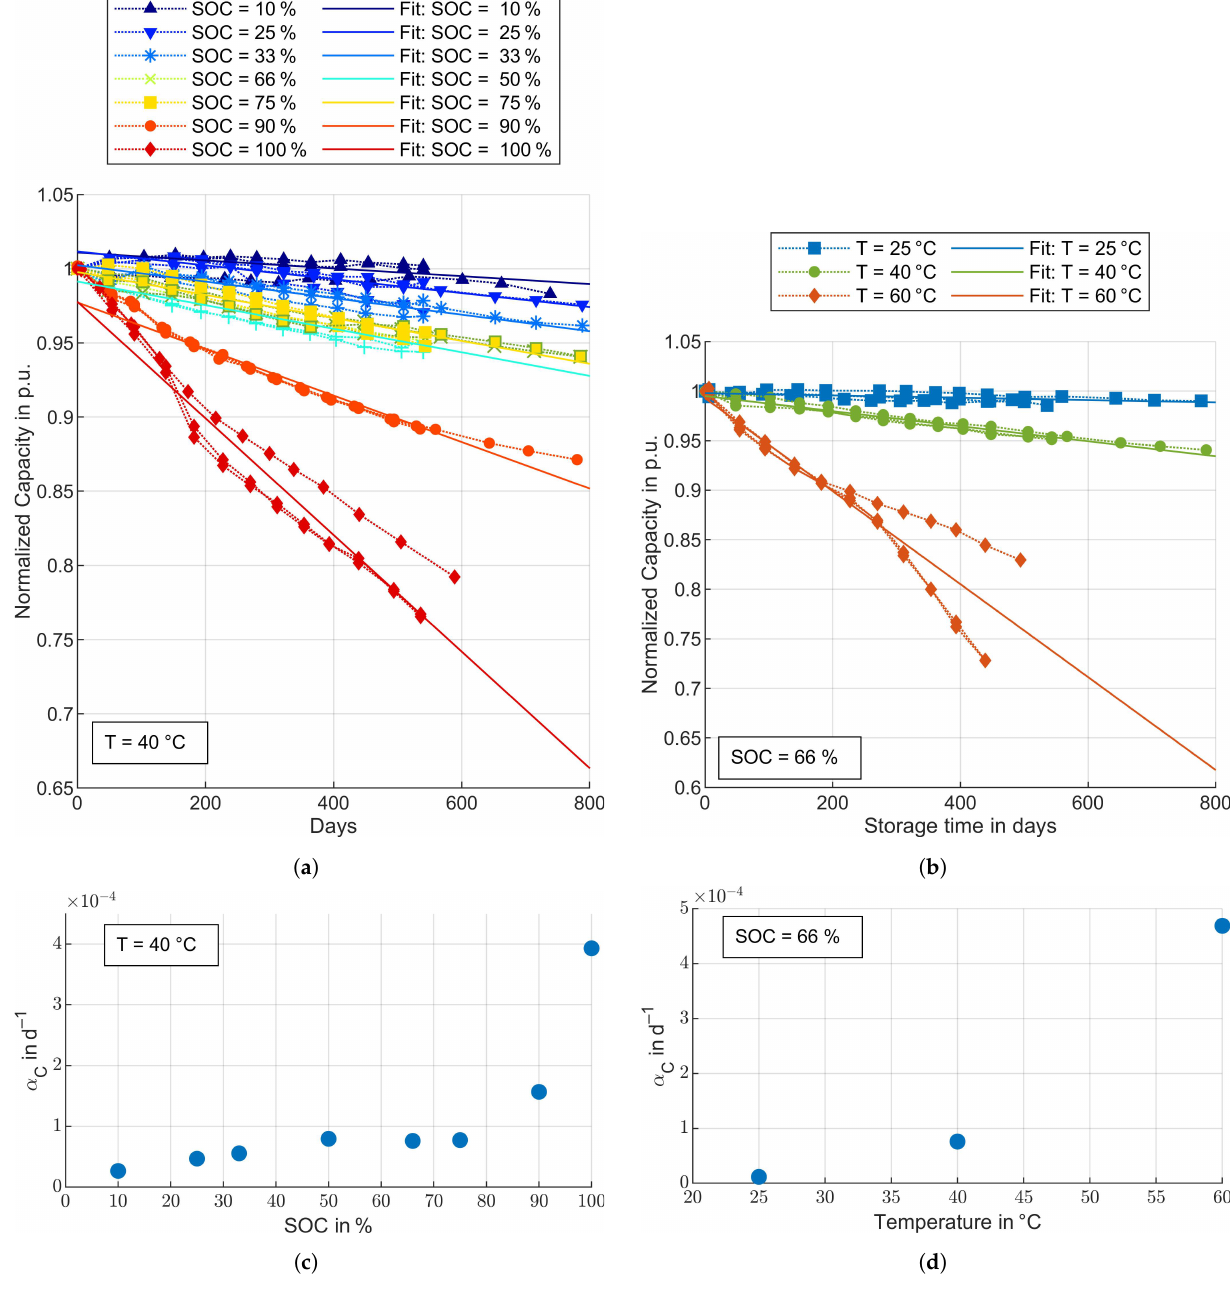
Figure 8. Capacity test and time fit results for cell capacity in calendar aging tests. ( a ) Capacity test and time fit results for cells stored at 40°C in the calendar aging tests; ( b ) Capacity test and time fit results for cells stored at 66% SOC in the calendar aging tests; ( c ) Linear coefficient α C of the time fit results for cells stored at 40°C in the calendar aging tests; ( d ) Linear coefficient α C of the time fit results for cells stored at 66% SOC in the calendar aging